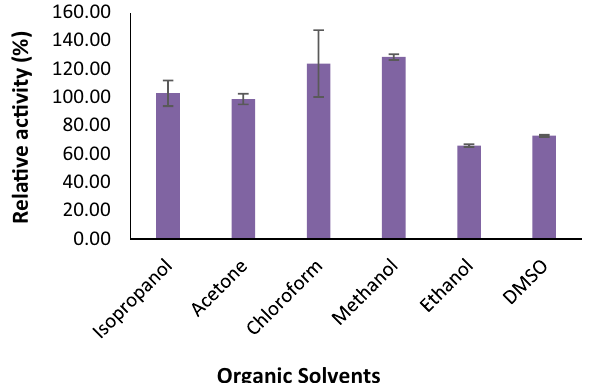
Figure 7. Effect of different organic solvents on pectate Lyase activity from Paenibacillus lactis PKC5.